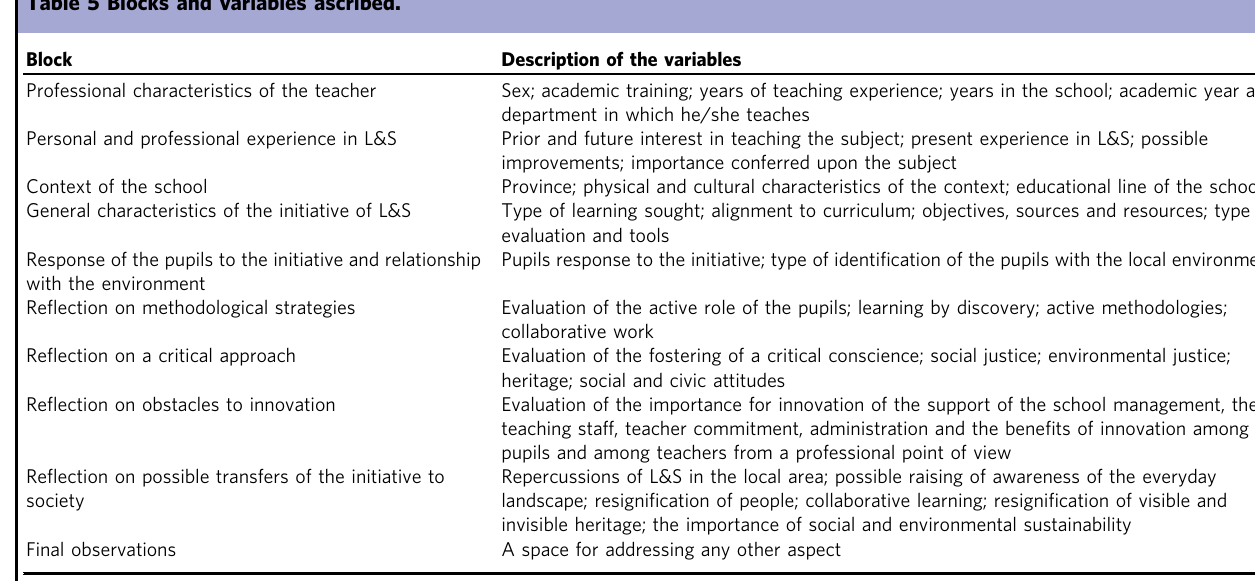
Table 5 Blocks and variables